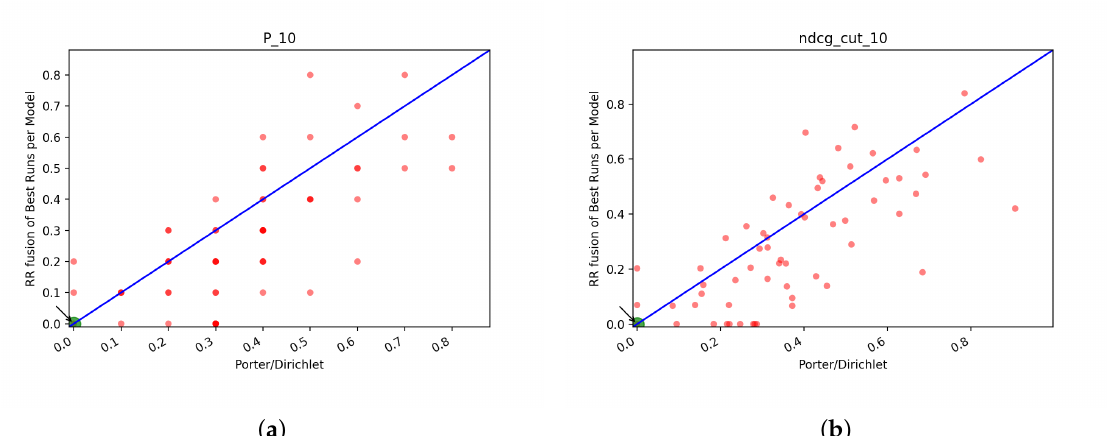
Figure 23. T1: scatter plots of P@10 and NDCG@10 of Porter/DirichletLM vs. RR fusion of best runs